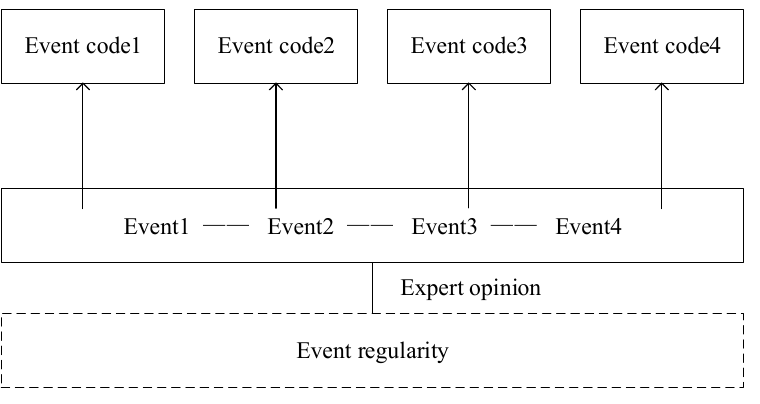
Figure 6. Shili Mirrored Structure based on the information storage mechanism.